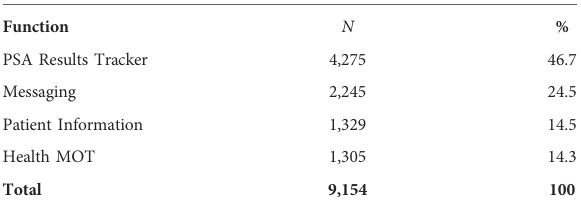
TABLE 3 Portal web page views over a 6 month period.